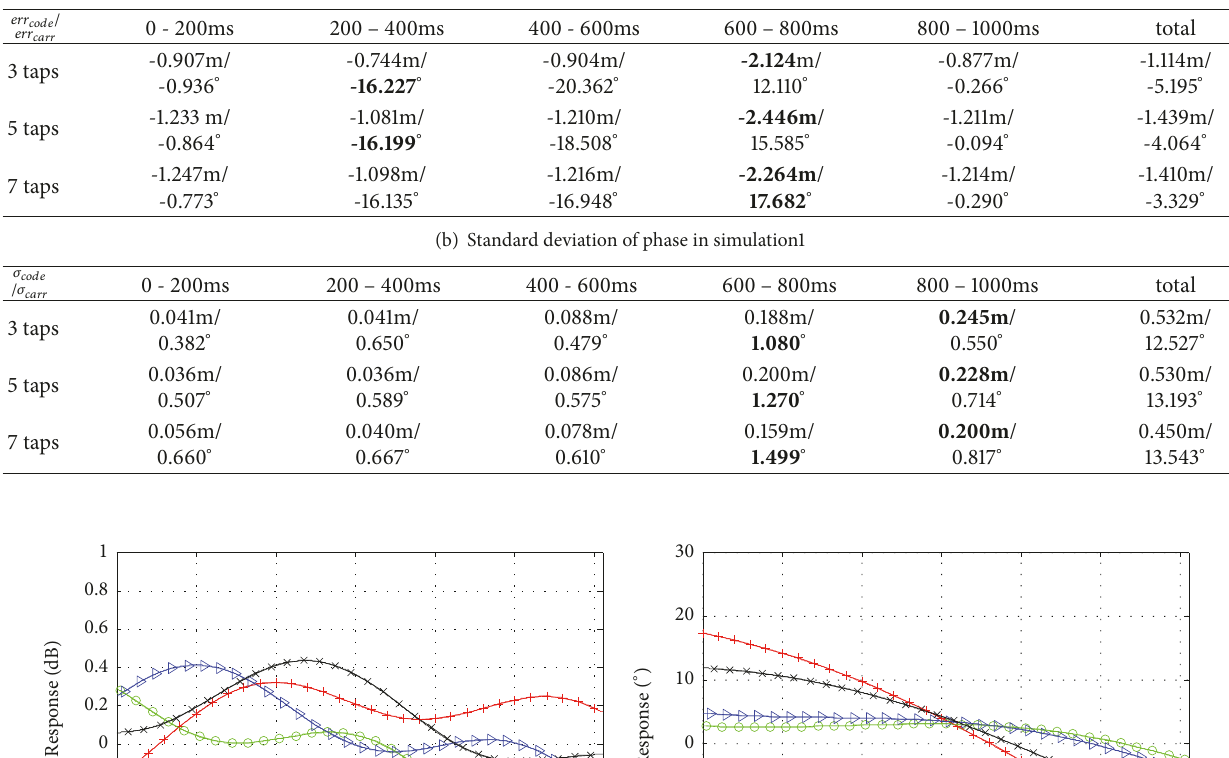
(a) Average phase error in